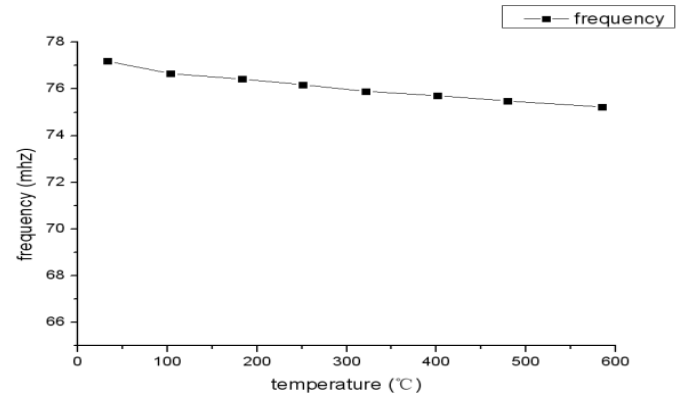
Figure 12. Sensor resonant frequency versus temperature.